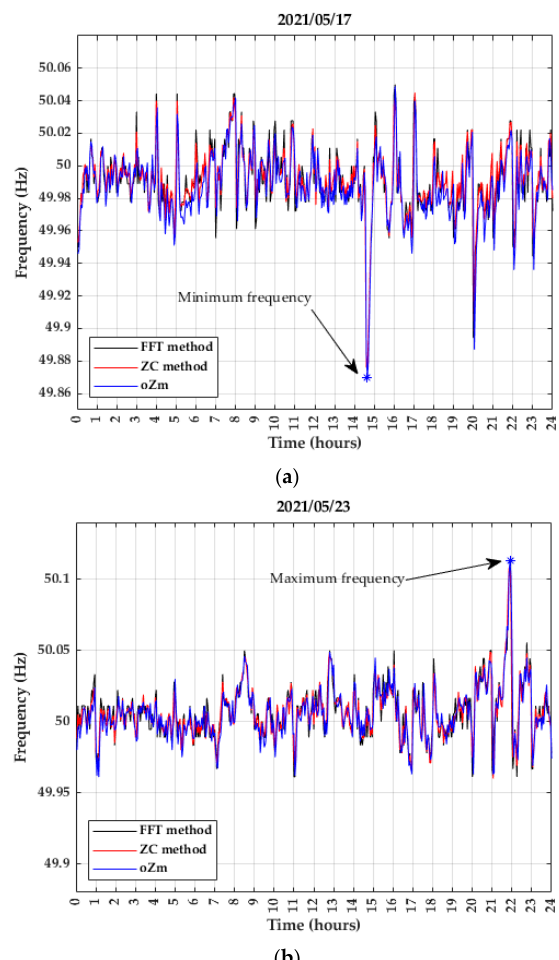
Figure 12. Daily grid frequency variation ( a ) Monthly minimum value of May 2021; ( b ) Monthly maximum value of May 2021.